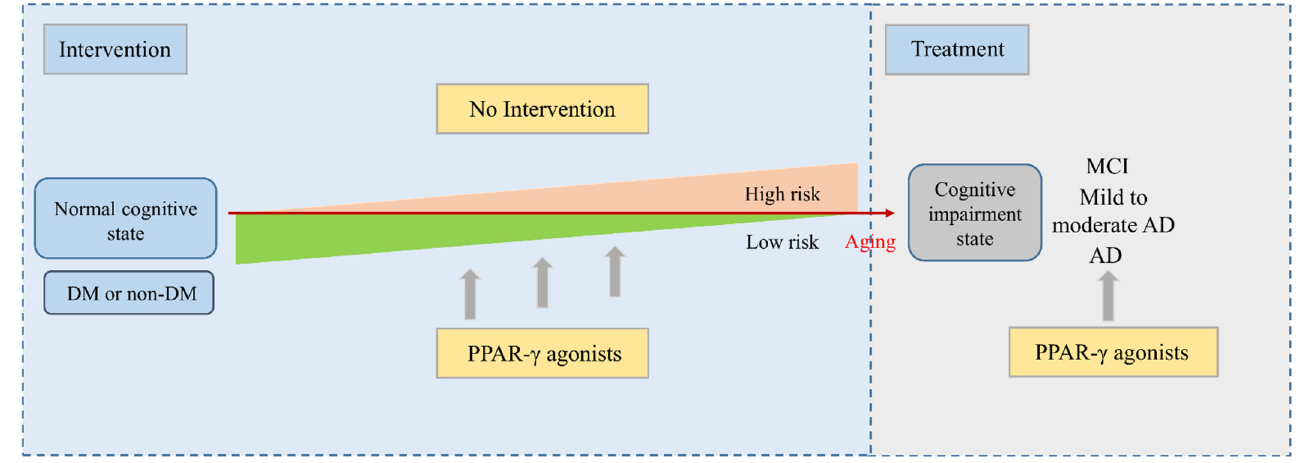
Figure 4. PPAR- γ agonist treatment plays an important role in disease progression (early intervention and later treatment).